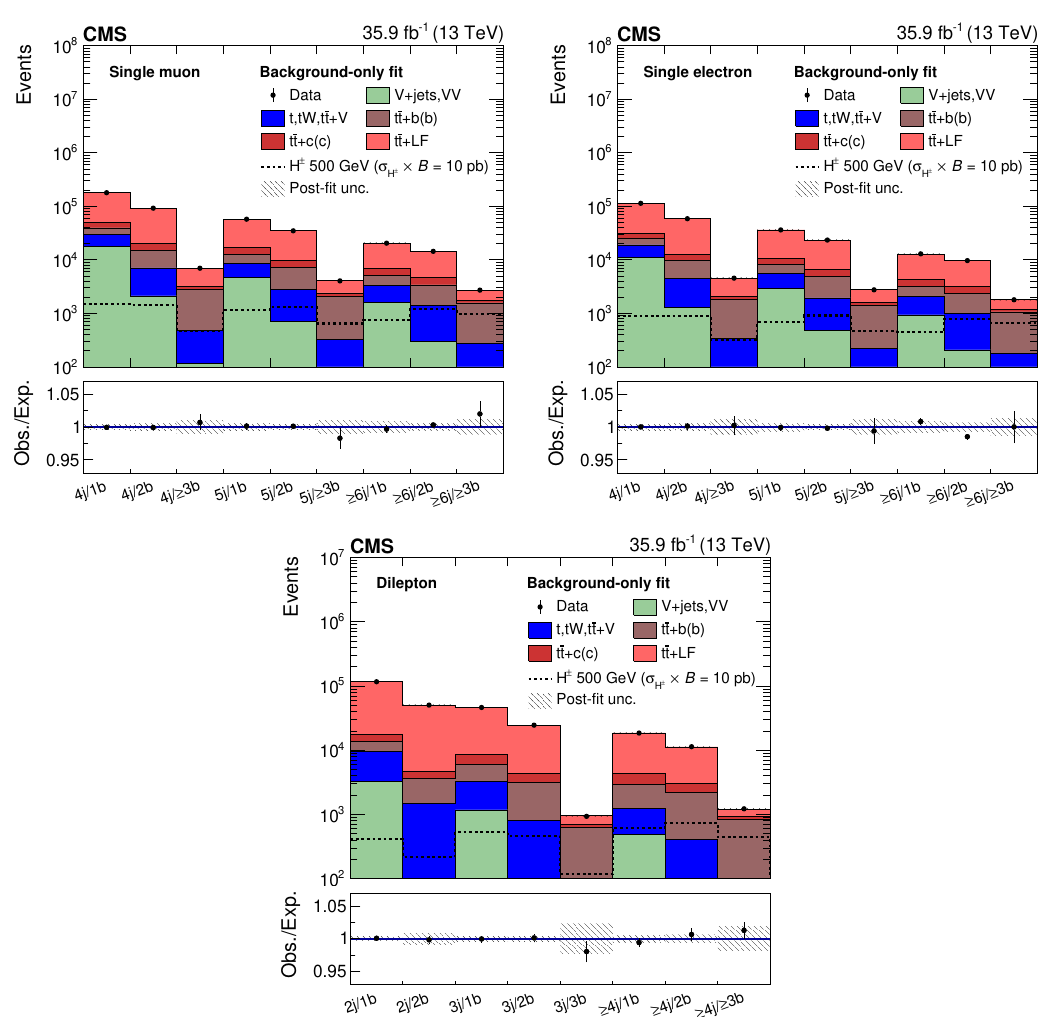
Figure 3 . Summary of event yields in each analysis category for single-muon (top left), single- electron (top right), and dilepton (bottom) (cid:12)nal states. The yields observed in data (black markers) are overlaid. The solid histograms represent the background prediction for tt+LF (light red), tt+c(c) (dark red), tt+b(b) (brown), single top quark and tt in association with extra bosons (blue), and V+jets and multiboson production (light green). The dashed line represents the yields for a charged Higgs boson with a mass of 500 GeV and a product of the cross section and the branching fraction of 10 pb. The lower panel shows the ratio of data to the SM expectation after the background-only (cid:12)t to the data and the hatched uncertainty bands include the total uncertainty. are accounted for in the quoted uncertainties. The contribution of a hypothetical charged Higgs boson with a mass of 500 GeV and (cid:27) (H (cid:6) tb) = 10 pb is also displayed. In H (cid:6) B ! the same con(cid:12)guration, (cid:12)gure 4 shows the MVA (BDT and DNN) outputs in exemplary signal-region subcategories for the single-lepton (5j/ 3b) and dilepton (3j/3b) (cid:12)nal states. (cid:21) The data agree with the background distributions and no signi(cid:12)cant excess is ob- served. Exclusion limits are set at 95% con(cid:12)dence level (CL) on (cid:27) (H (cid:6) tb) for m H (cid:6) B H (cid:6) !